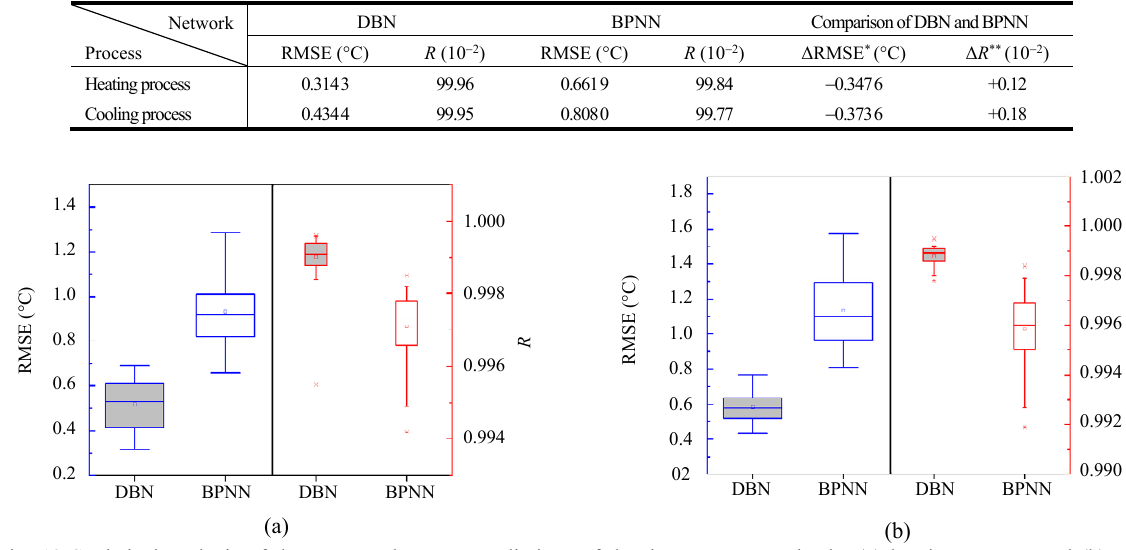
Fig. 12 Statistical analysis of the DBN and BPNN predictions of the three-turn HMF in the (a) heating process and (b) cooling process. “ — ” represents the median,  is the average value. The outlier is denoted by